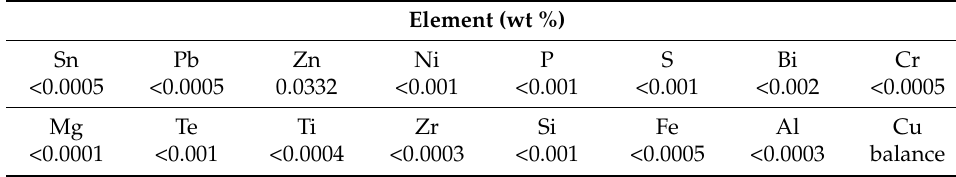
Table 1. Chemical analysis of commercially pure Cu used as base material in this work.